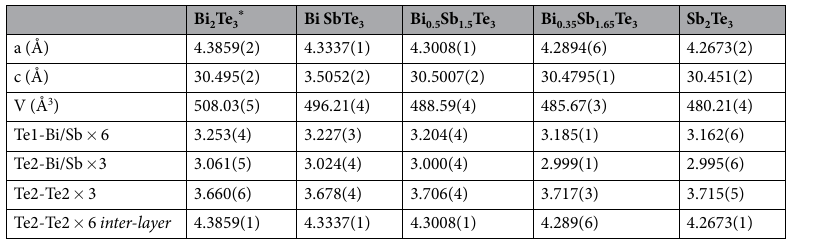
Table 1. Unit-cell parameters and main interatomic distances in the Bi 2 − x Sb x Te 3 system from NPD data. * From ref.